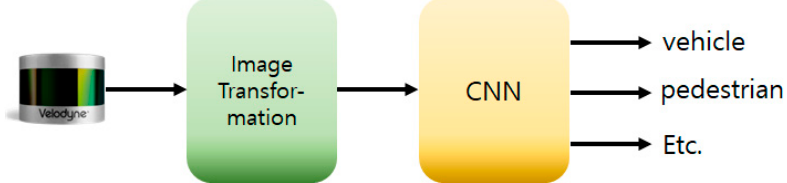
Figure 2. Network structure based on image transformation.